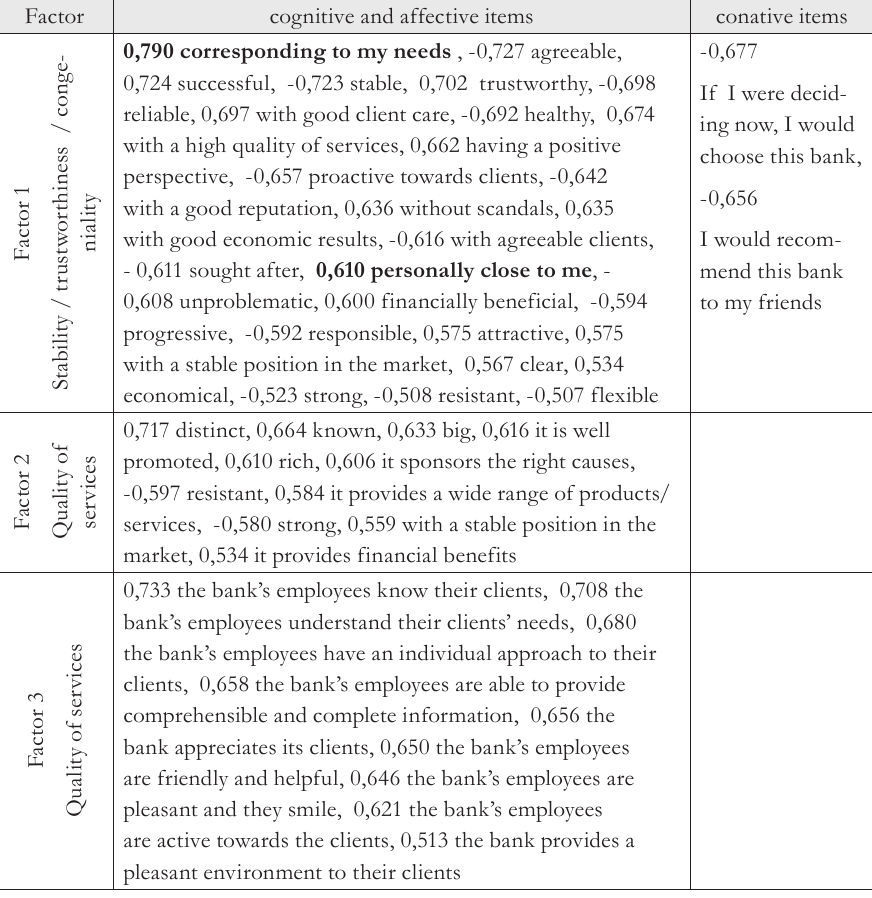
Tab. 7 - Bank 3: A description of the content of the extracted factors. Source: author. Factor cognitive and affective items conative